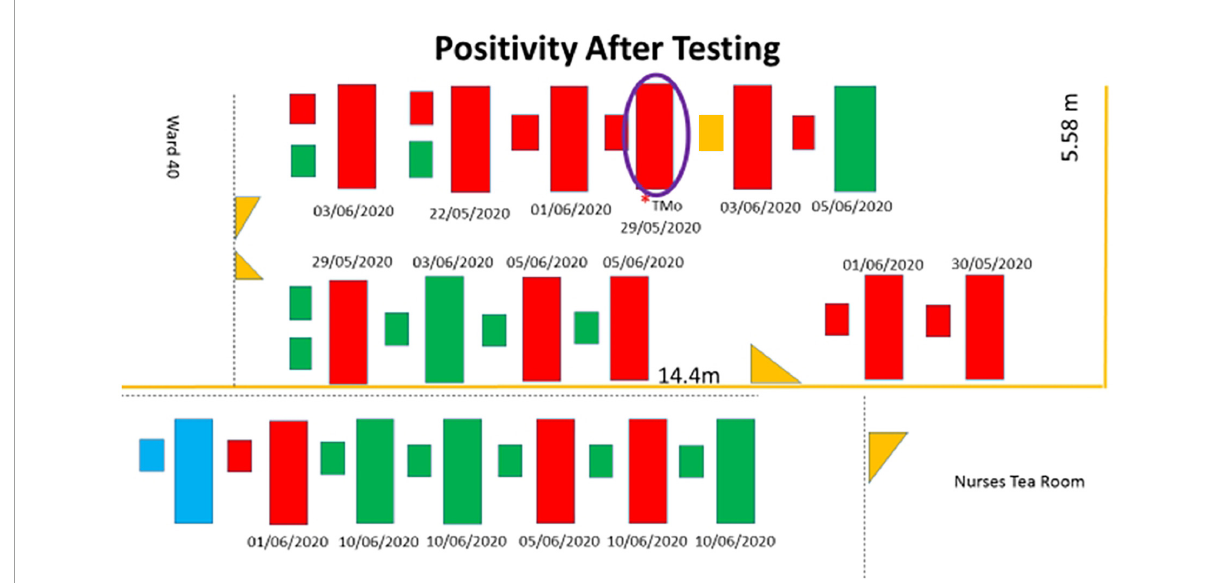
FIGURE1 Schematic representation with the mothers and neonates who tested positive shaded in red. The beds shaded in green are mothers and neonates who tested negative, and the beds shaded in blue are not occupied. The large rectangle represents the maternal beds, the smaller rectangles adjacent to the large rectangles represent neonatal beds, and two smaller rectangles represent a set of twins. The purple circle represents the index case. The small orange rectangle represents the neonate who was not tested. Yellow triangles are doors. The dates below the beds are the dates of admission to the KMC